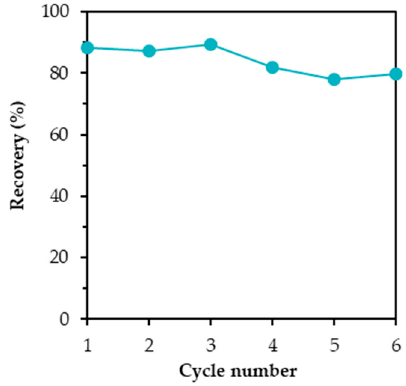
ff ect of the adsorbent reuse on preconcentration and determination of Figure 5. Effect of the adsorbent reuse on preconcentration and determination of cadmium. E